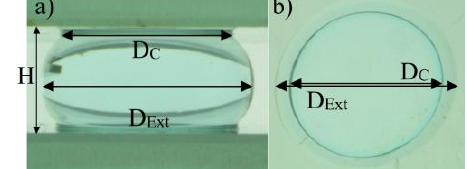
Fig. 2. Characteristics diameters (D Ext y D C ) of a hydrated hydrogel under confinement, H = 8 mm. a) Side view. b) Top view.